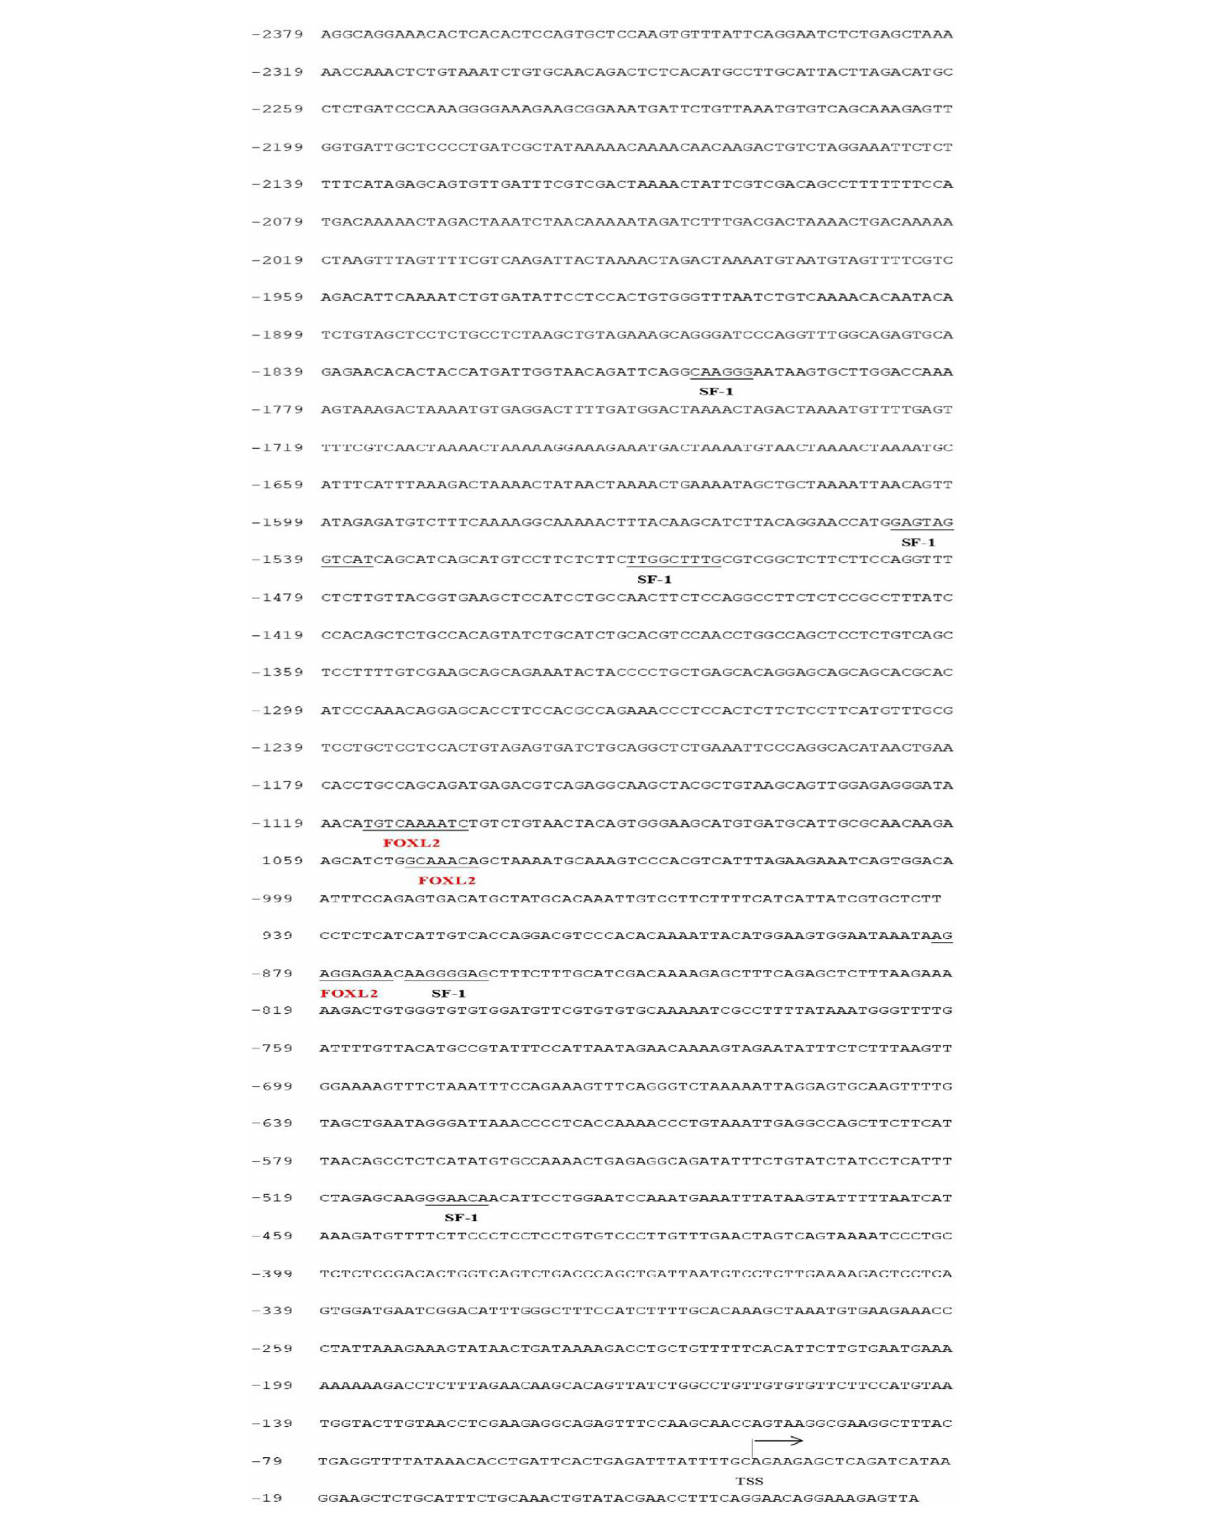
FIGURE 7 | Predicted binding sites of SF-1 and FOXL2 on cyp19a1b promoter sequence. The underlined location is the binding site of the predicted transcription binding factor on the initiation. Numbers indicate the distance between the rightmost base in the row and the base of the transcription initiation codon. TSS: Initial site, arrow direction: transcriptional